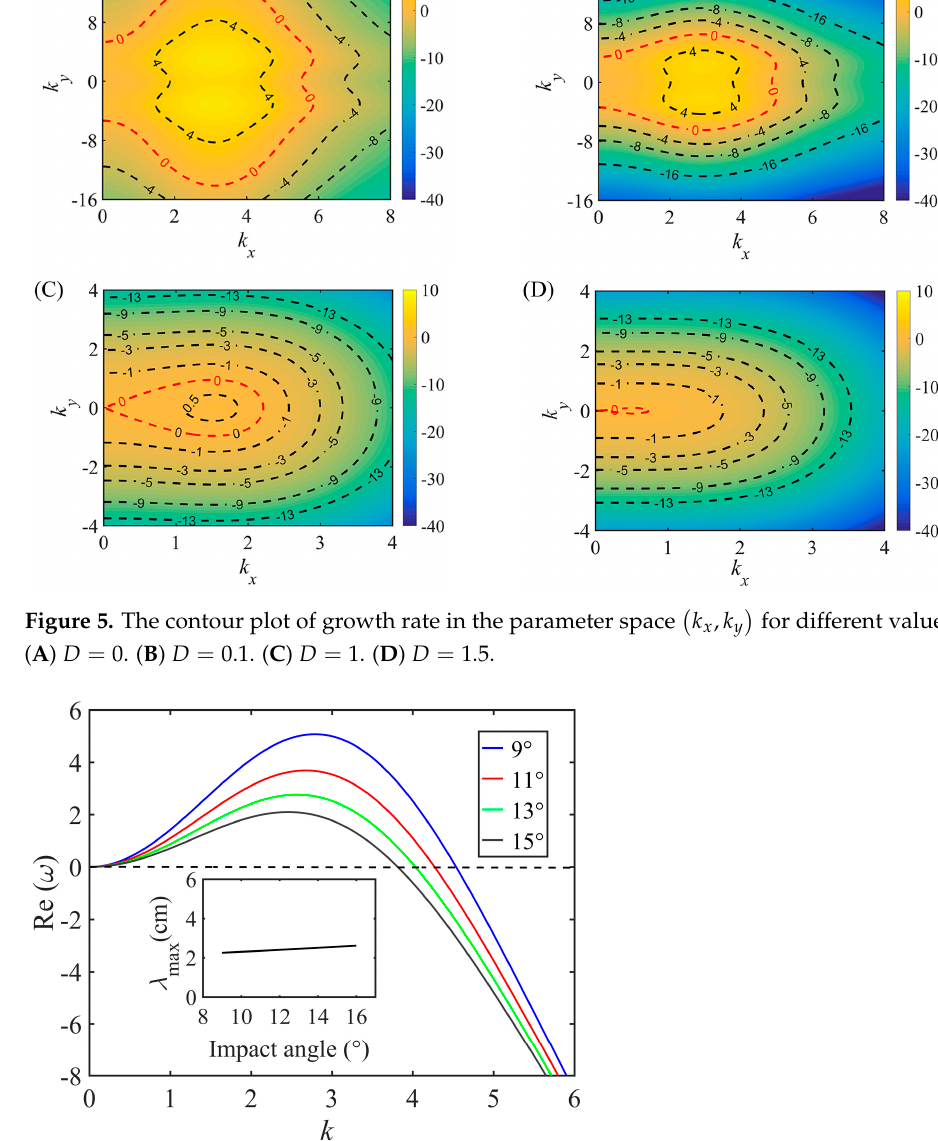
Figure 6. The growth rate plotted versus the wavenumber k x , fixing k y = 0 for different impact angle. The insets show the wavelength of the preferred mode as function of the impact angle.